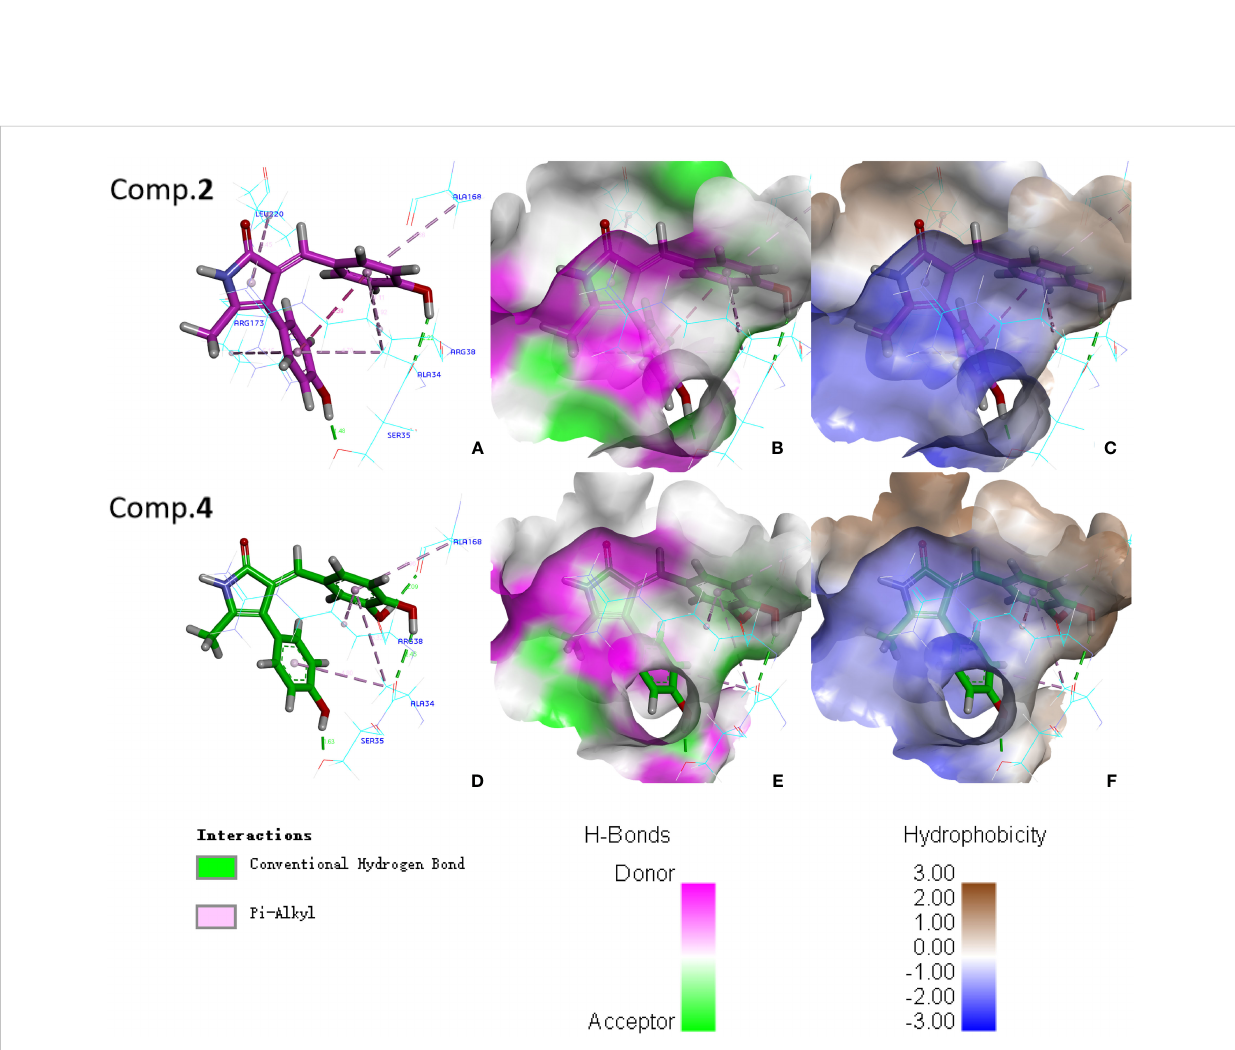
FIGURE 7 Molecular docking analyses of compounds 2 and 4 with POD: (A) Interactions between compound 2 and amino acid residues of POD; (B) H-bonds between compound 2 and active pocket of POD; (C) Hydrophobic property between compound 2 and active pocket of POD; (D) Interactions between compound 4 and amino acid residues of POD; (E) H-bonds between compound 4 and active pocket of POD; (F) Hydrophobic property between compound 4 and active pocket of POD.